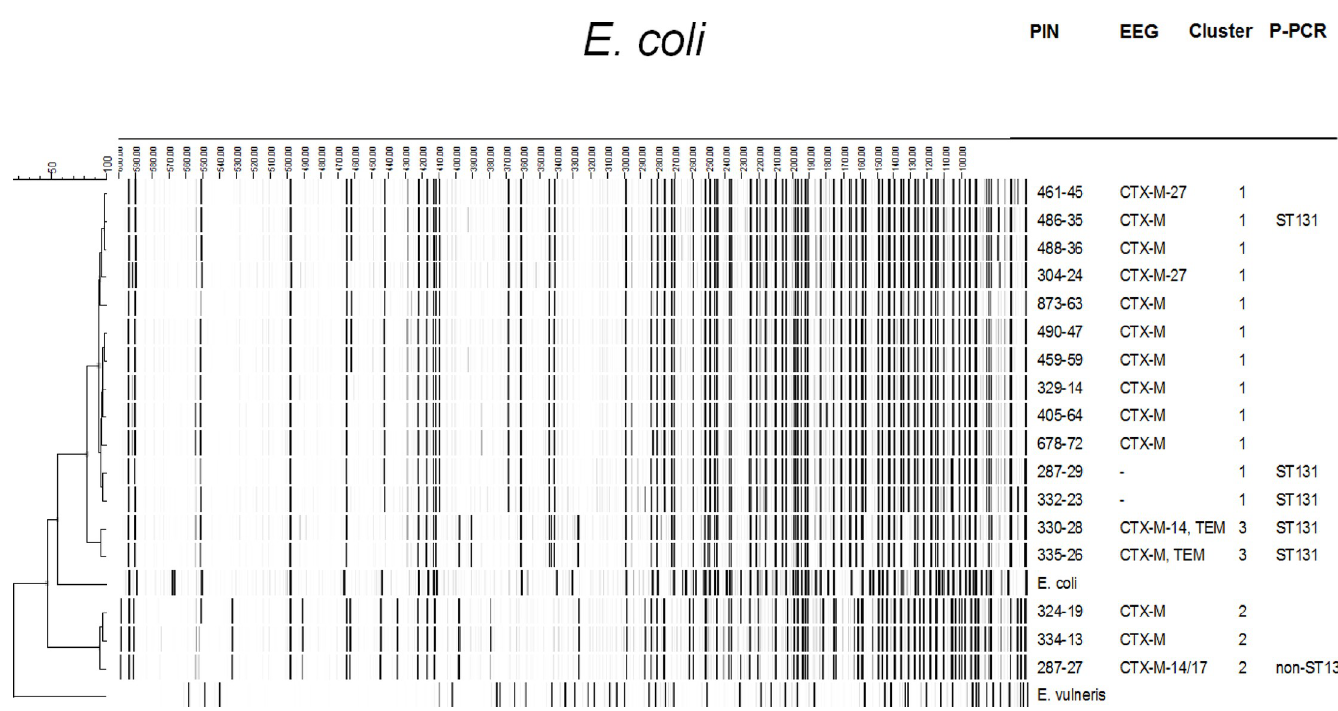
Fig 2. E . Coli isolates from clusters 1–3. Abbreviations: PIN = Patient Identification Number; EEG = ESBL Encoding Gene; P-PCR = Phylogroup defining Polymerase Chain Reaction.